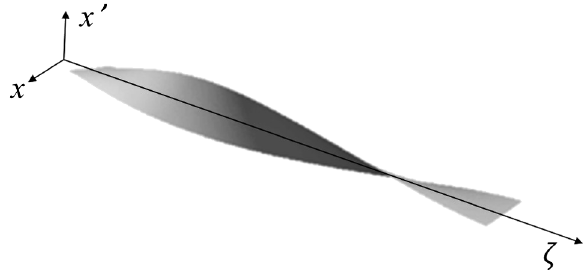
FIG. 7. One of Peterson ’ s figures from [15] showing the initial (just after the tapered foil) and final horizontal phase spaces (top) and the initial and final x -energy correlations